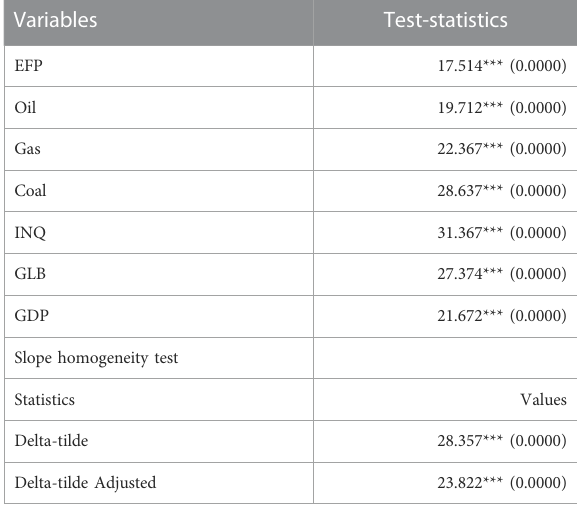
TABLE 1 CSD and slope homogeneity results.